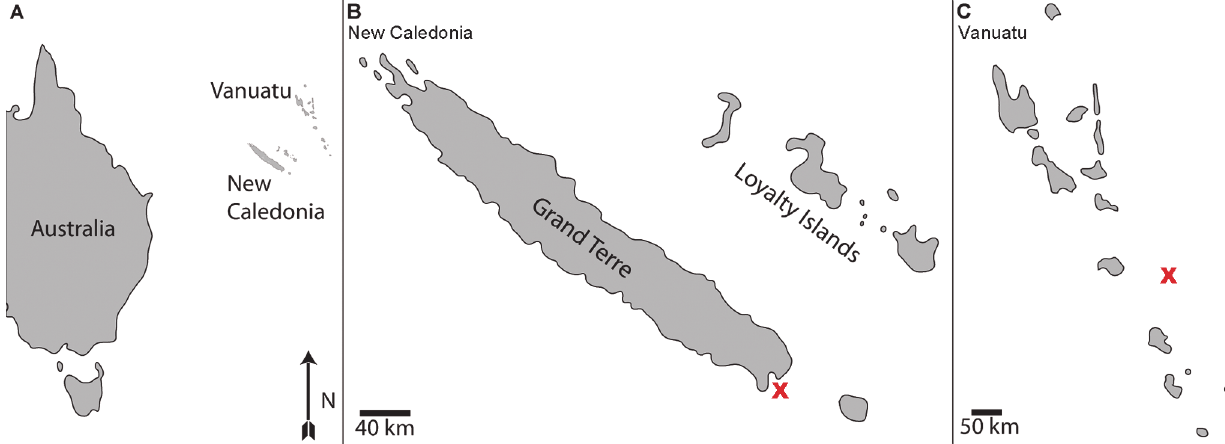
Fig 1. Geographical position of the sample sites in the New Caledonia and Vanuatu regions. (A) Sampling sites (New Caledonia and Vanuatu) of the Nautilus specimens east of Australia. (B) Sampling site of Nautilus macromphalus specimens near New Caledonia marked with a cross. (C) Sampling site of Nautilus pompilius near Vanuatu marked with a